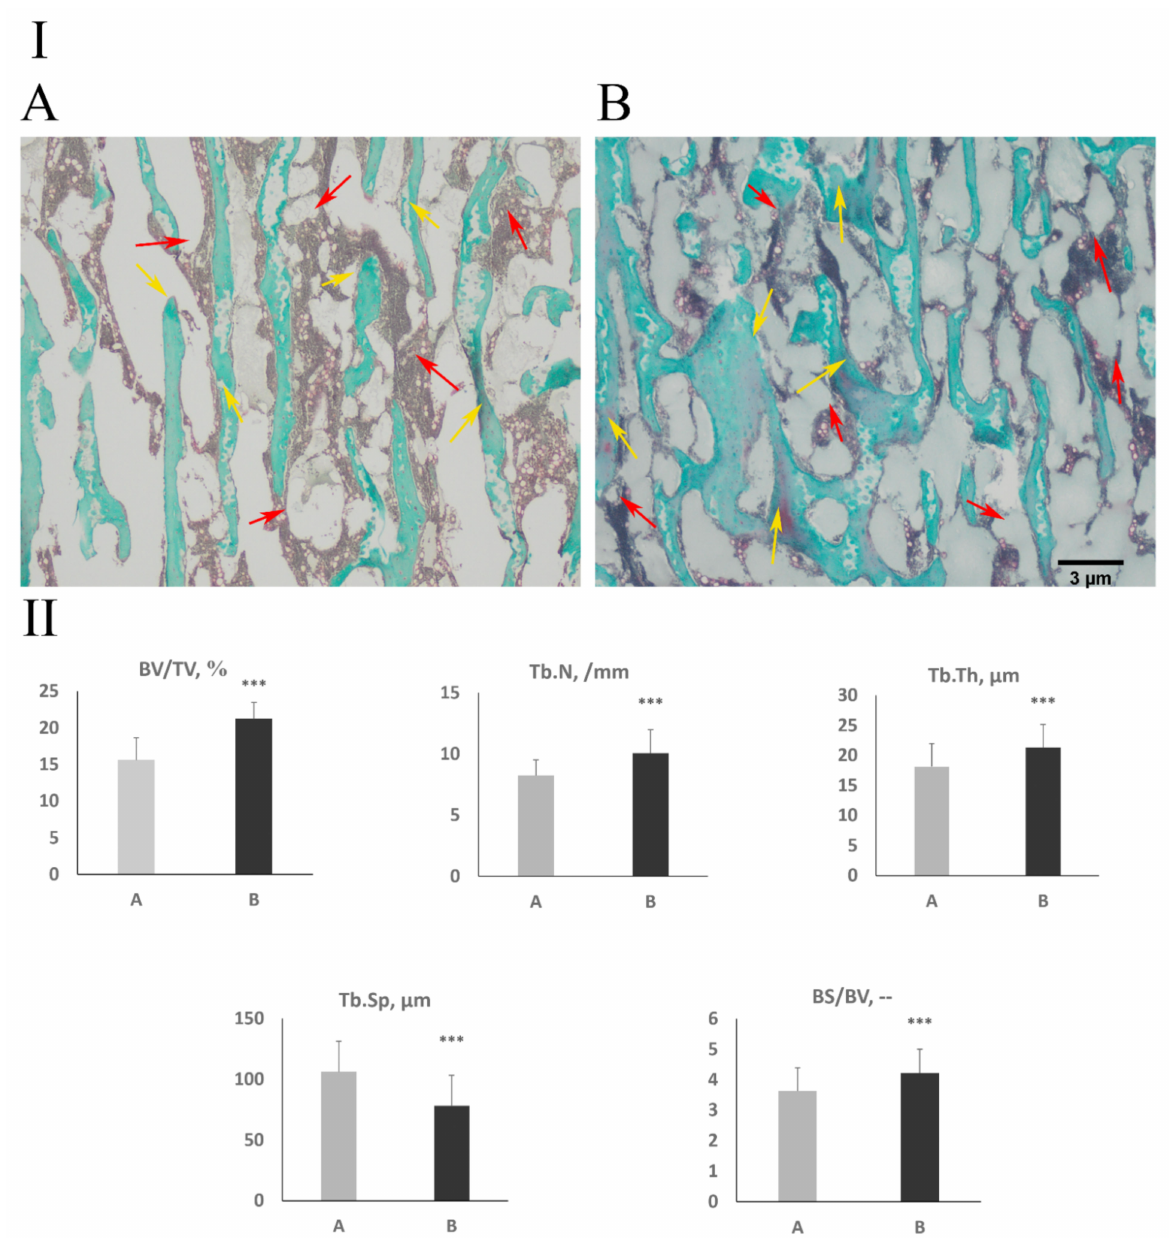
Figure 2. Trabecular bone morphology from proximal part of the tibia bone in examined animals of the age of 42 days. ( I ) Representative pictures of Goldner Trichome method staining carried out on formaldehyde-fixed samples from the cancellous bone. The yellow arrows show the trabeculae, while the red arrows show the bone marrow. ( II ) BV/TV-relative bone volume. Tb.Th, trabecular thickness; Tb.Sp, trabecular separation; Tb.N, trabecular number; BTD, bone tissue density; BS/BV, bone surface density. Control group (A); experimental group (B). Data are mean values ± SD (whiskers) from n = 10 birds. Statistical significance: *** p < 0.001 (two-tailed Student’s t- test, t -test with Welch’s correction, or Mann–Whitney U